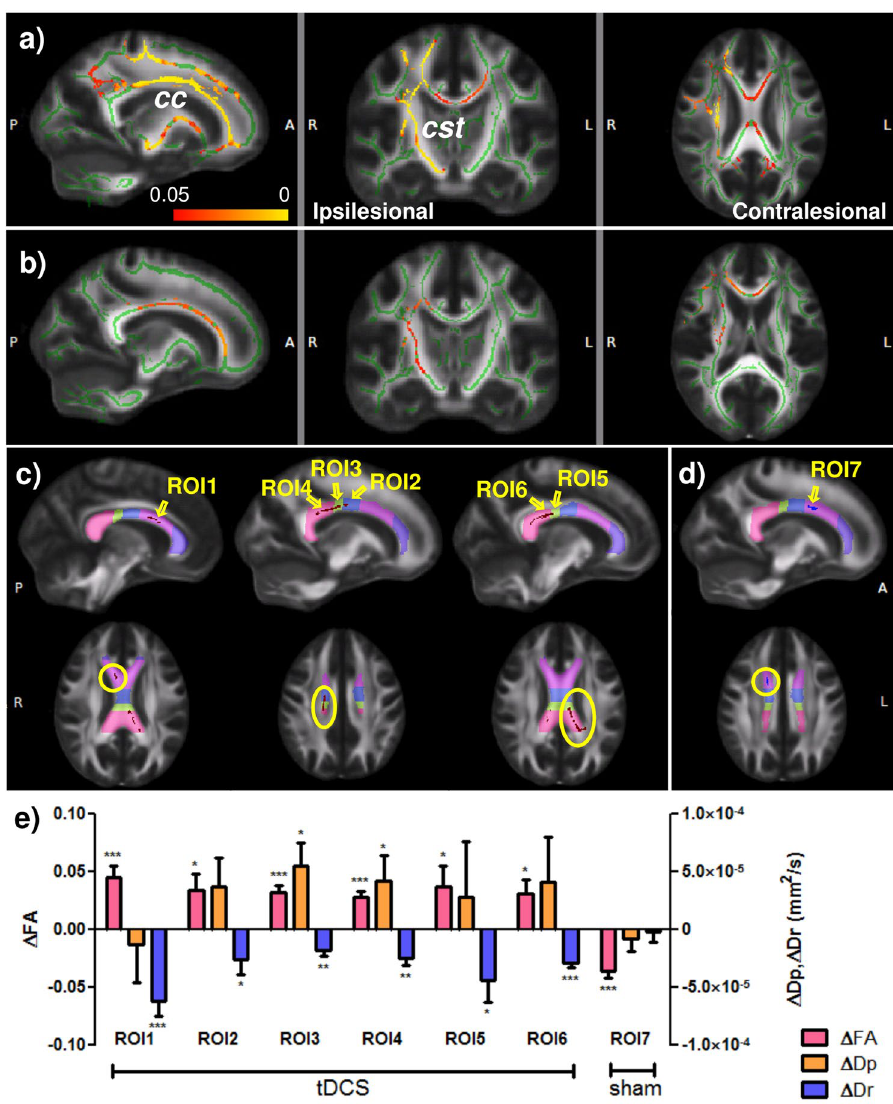
Figure 3. DTI results. ( a ) FA at baseline in all patients is significantly lower (highlighted in red-yellow) compared to healthy control (p < 0.05 FWE corrected). ( b ) tDCS group has larger FA increase in the cc and cst than the sham group (p < 0.05 FWE corrected). Lesion is on the Right side. The white matter skeleton (in green) is superimposed on the FMRIB58_FA template. cc : corpus callosum; cst : corticospinal tract. ( c ) and ( d ) White matter diffusivity change in the corpus callosum. ( c ) ROIs for the tDCS group in the 2 nd (ROI1), 3 rd (ROI2), 4 th (ROI3), and 5 th (ROI4) section of the ipsilesional cc , and in the 4 th (ROI5) and 5 th (ROI6) section of the contralesional cc . ( d ) ROI for the sham group in the 2 nd section of the ipsilesional cc (ROI7). Segmentation of the cc is denoted by colors as such: connecting prefrontal cortex (purple); premotor and supplementary motor cortices (magenta); motor cortex (blue); sensory cortex (green); and parietal, temporal, and occipital cortices (pink). ( e ) The tDCS group shows significant increase of FA due to changes in Dp and/or Dr in the ROIs. No Dr or Dp change was found in the region with decreased FA in the sham group. * p < 0.05; ** p < 0.01; *** p < 0.001. Error bar represents